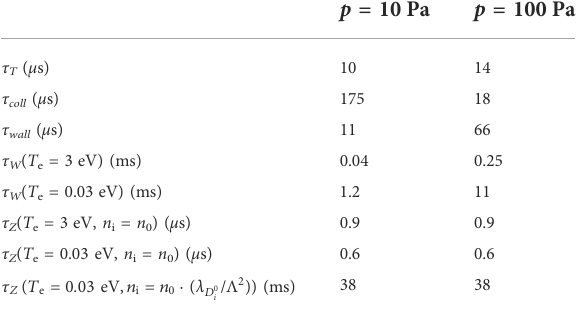
TABLE 1 Afterglow time scales for an argon plasma for two pressures. A cylindrical chamber with R = l = 4 cm ( Λ = 1 cm) is considered. The plasma parameters at the beginning of the afterglow phase are T T n n T − 3 . The electron- e = 3 eV, i = gas = 0.03 eV, and e = i = 10 9 cm neutral elastic collision rate is set to K el = 10 – 13 m 3 /s, and the ion- neutral cross-section is set to σ i = 10 – 18 m 2 . A single particle of radius r d = 5 μ m is